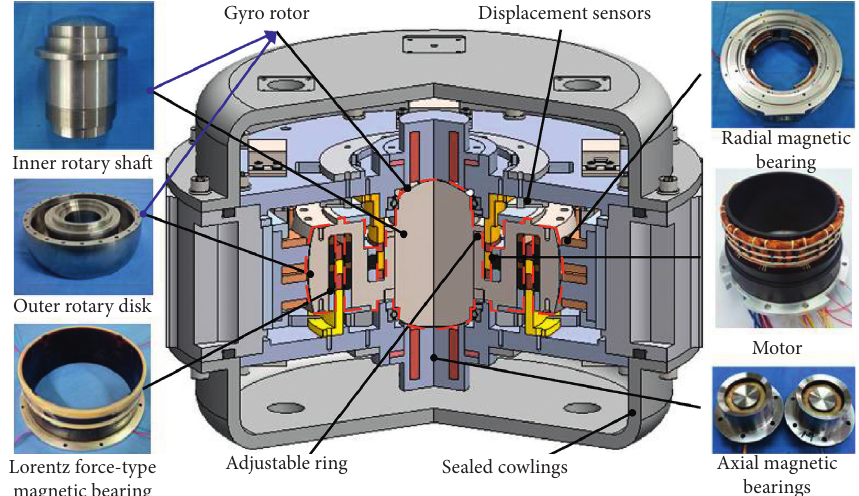
Figure 1: Configuration of